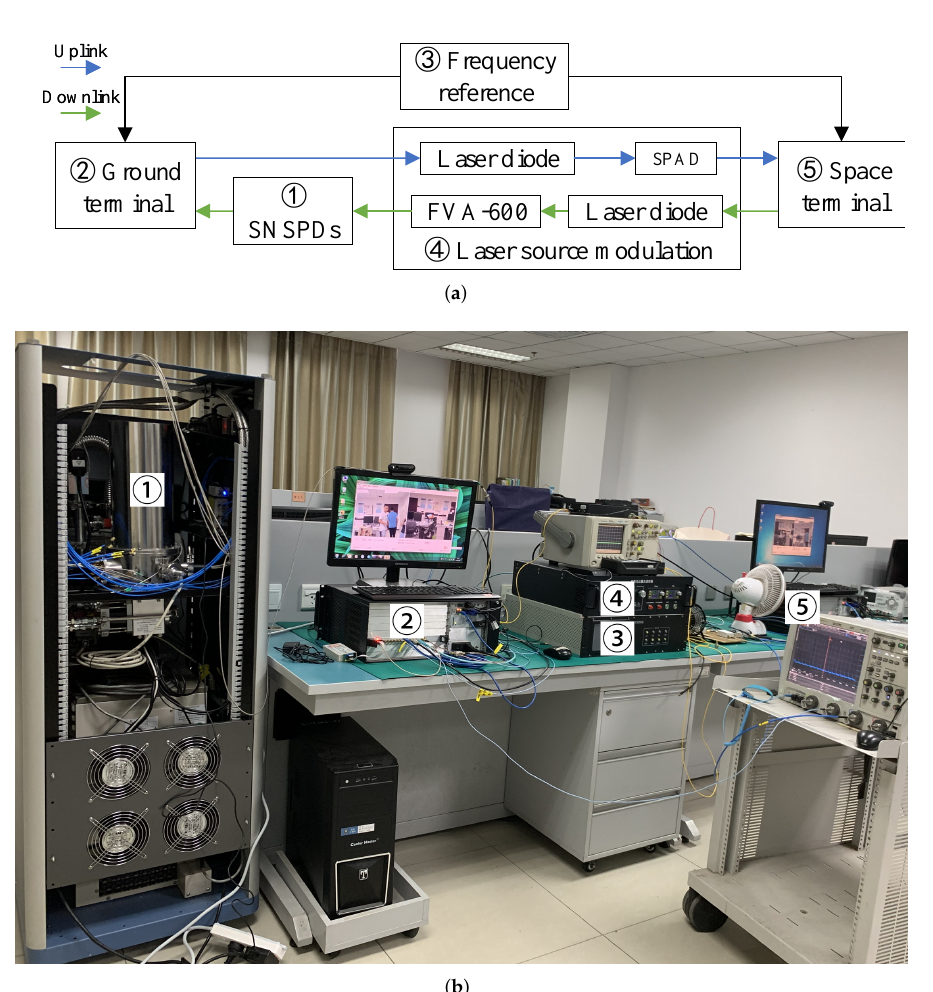
Figure 8. Structure of the hardware platform: ( a ) Topology of the hardware platform. ( b ) Photograph of the hardware platform.